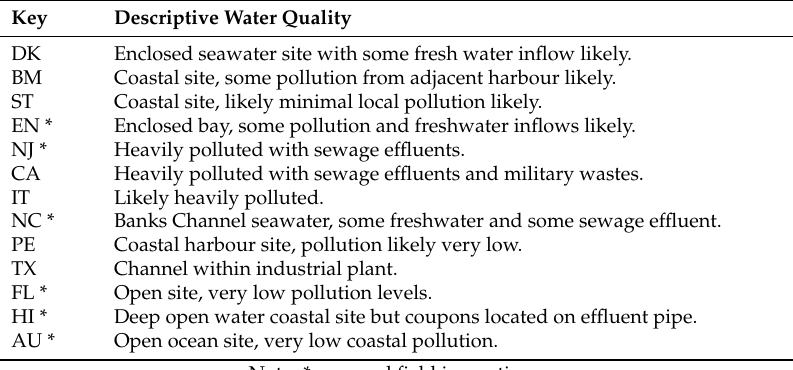
Table 3. Qualitative descriptions of water quality for exposure sites [11].